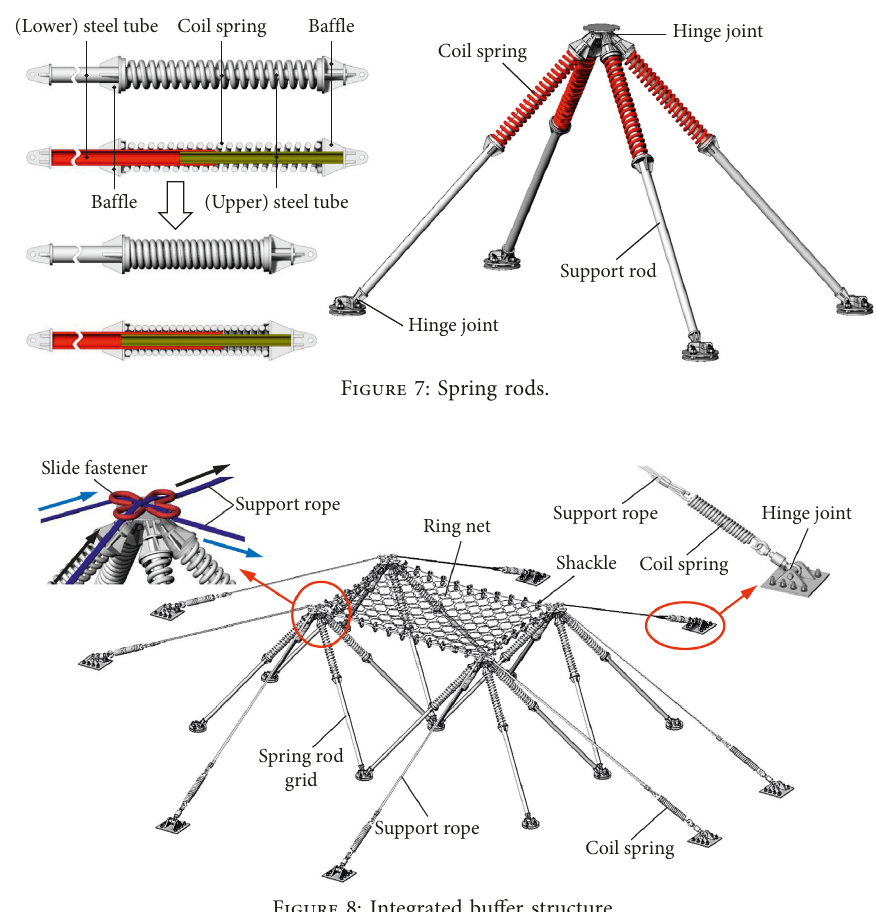
Figure 8: Integrated buffer structure.